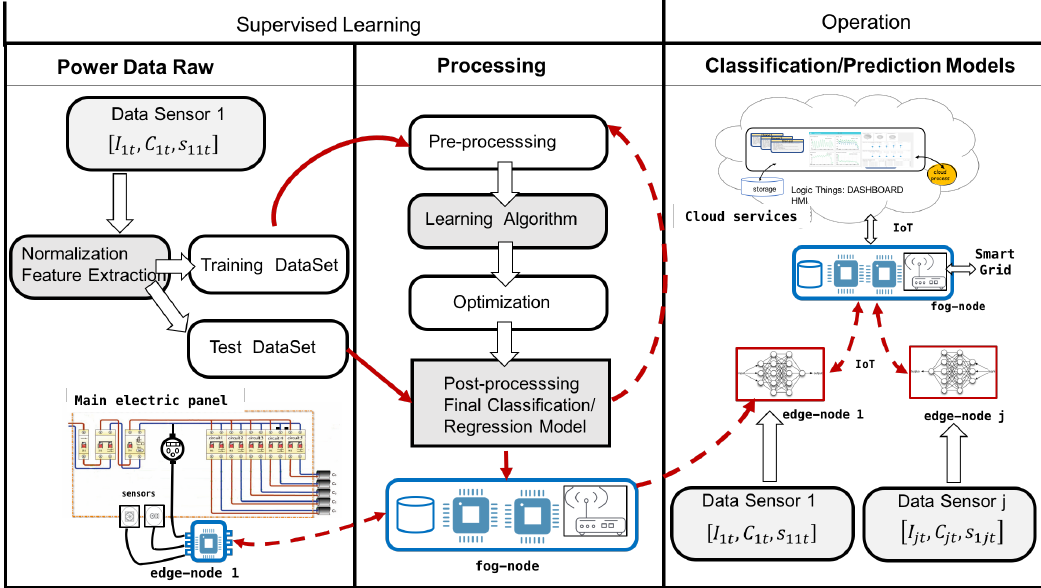
Figure 11. Learning and operation process in classification and load